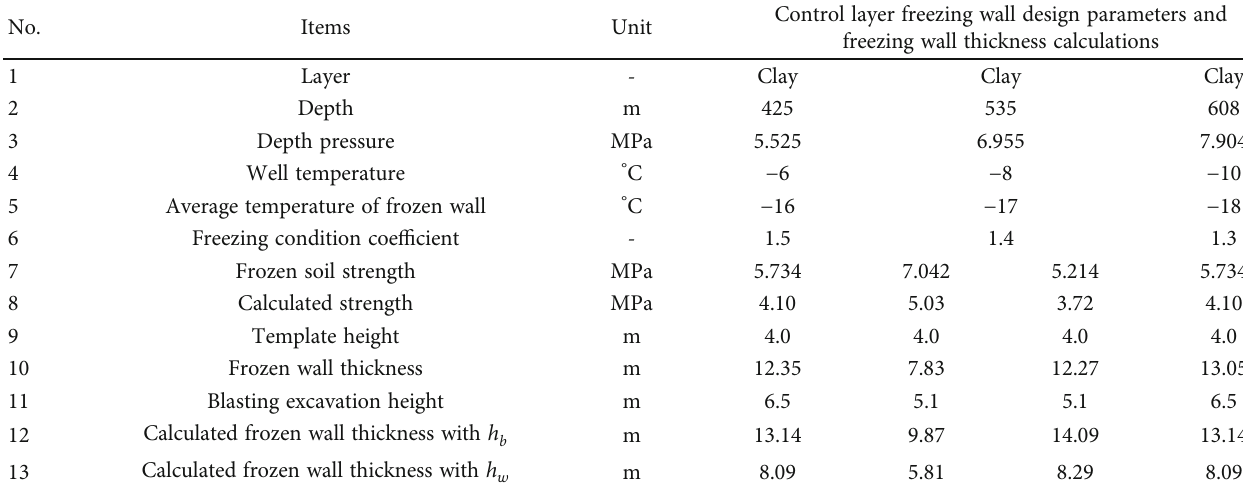
Table 4: Results of the frozen wall thickness calculated according to the in situ frozen soil parameters in the control layer of the west air shaft of Zhaogu No. 2